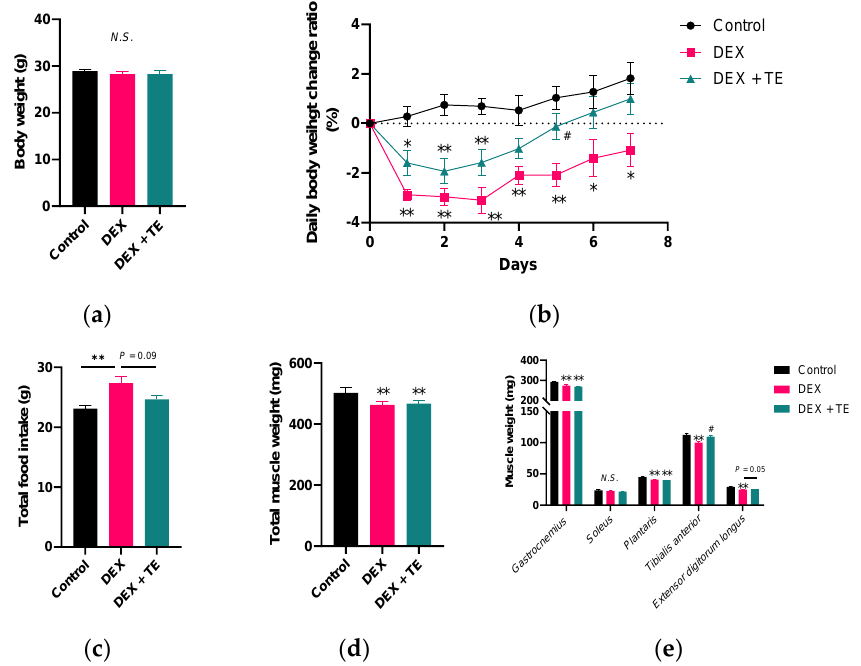
Figure 1. Effects of 2% turmeric extract (TE) supplementation on body weight, food intake, and muscle weight in dexamethasone (DEX)-treated mice. ( a ) Final body weight. ( b ) Daily body weight change ratio. ( c ) Total food intake. ( d ) Total muscle weight. ( e ) Weight of five types of leg muscle. The results are shown as the mean ± standard error and statistical analysis was performed by Tukey– Kramer test. Control group: n = 7; DEX and DEX + TE groups: n = 6 each. * p < 0.05, ** p < 0.01 vs. Control, # p < 0.05 vs. DEX, N.S.: not